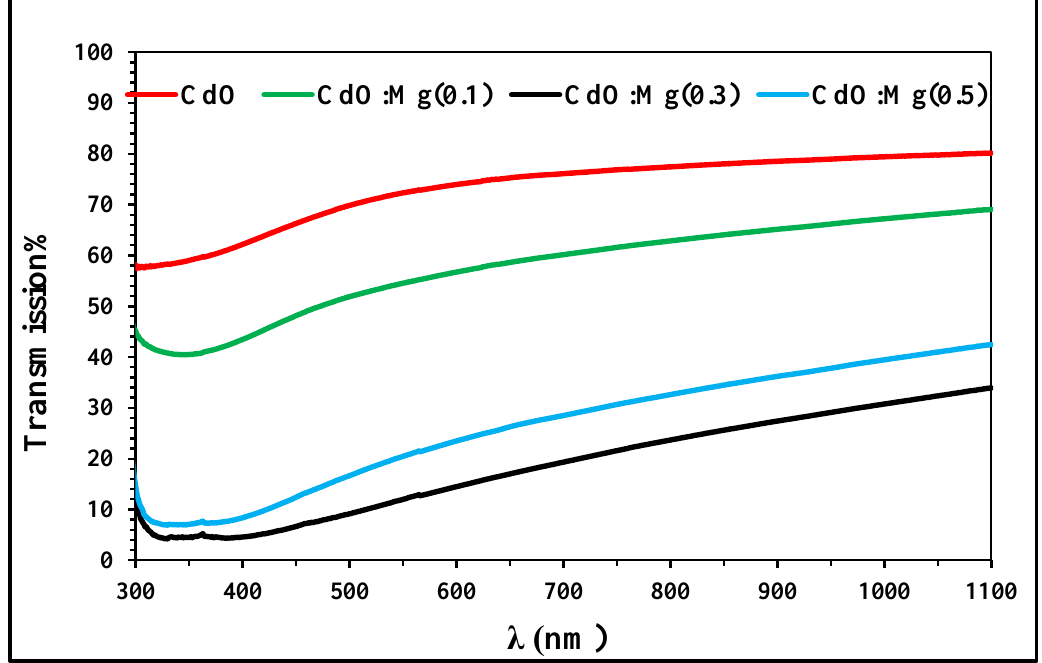
Fig.4: Transmittance spectrum as a function of the wavelength of pure CdO grafted films